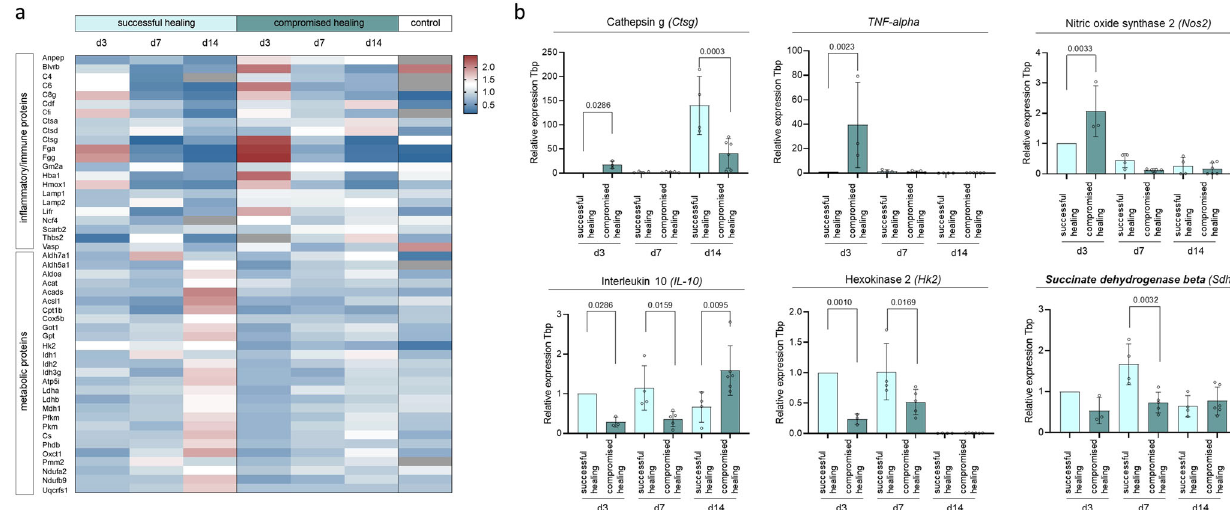
Fig. 4 Expression of selected metabolic and in fl ammatory genes from fracture tissue validates proteomic fi ndings of altered metabolism and in fl ammation between successful and compromised bone healing. a Heatmap of proteins related to the immune response and metabolism highlighting speci fi c pro fi les for successful and compromised healing. Day 3, in particular, showed increased levels of immune and in fl ammatory proteins in tissue of compromised healing fractures. Proteins from metabolic pathways showed an increasing trend in successful healing fracture tissue at day 7, and a strong upregulation compared to compromised healing at day 14. Shown are sum over mean normalized LFQ intensities, with following color coding, red = upregulated, white = unchanged between conditions, blue = downregulated, grey = no values. n = 3 – 5 biological replicates (BR) per group and time-point. b Gene expression analysis of selected in fl ammatory and metabolic markers validate fi ndings from protein levels. Pro-in fl ammatory genes like Ctgs, Tnf- alpha or Nos2 , showed signi fi cant higher expression in compromised healing samples. The anti-in fl ammatory gene Il-10 and enzymes from central carbon metabolism ( Hk2, Sdhb ) showed higher expression in samples from successful healing. Relative expression to Tbp (TATA-binding protein, housekeeping gene) and d3 young, n = 3 – 6 individual biological replicates per group and time point, One-way ANOVA, mean±standard deviation.